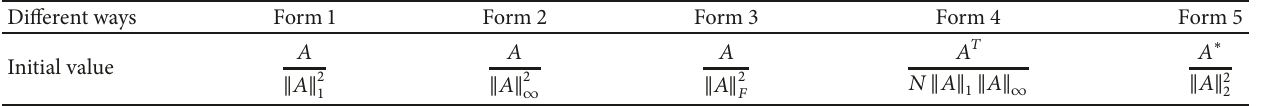
Table 2: Several choices for 𝑉 0 (for calculating 𝐴 −1